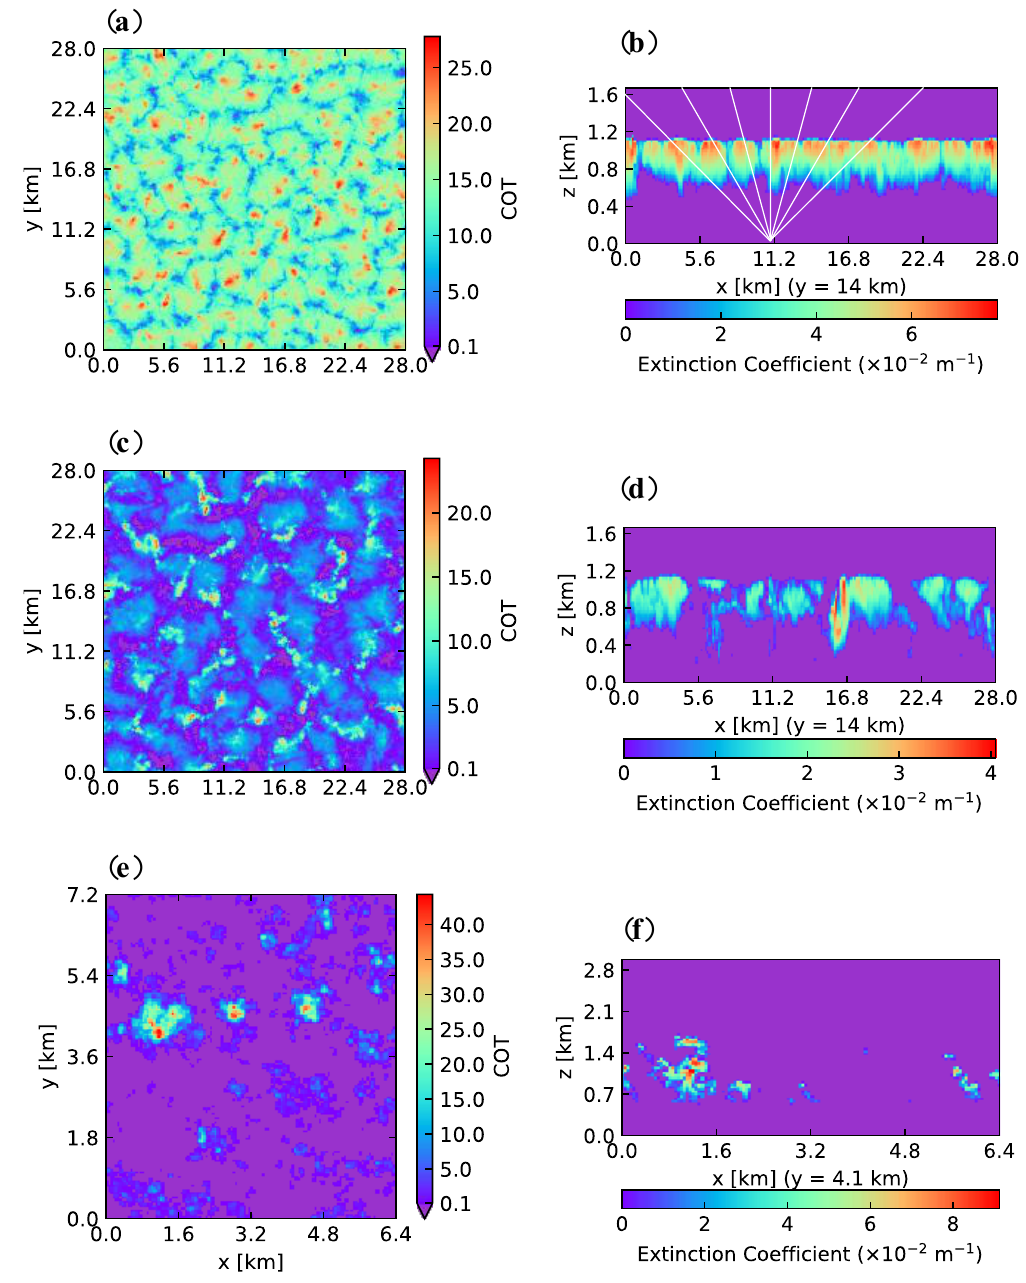
Figure 1. Examples of Scalable Computing for Advanced Library and Environment-Large Eddy Simulation (SCALE-LES) cumulus cloud fields for the following three cases: ( a , b ) closed-cell, ( c , d ) open-cell, and ( e , f ) Barbados Oceanographic and Meteorological Experiment (BOMEX). ( a,c,e ) Horizontal distribution of the cloud optical thickness (COT). ( b , d , f ) Vertical cross section of the volume extinction coefficient along the black dashed lines superimposed on ( a , c , e ), respectively. White lines in ( b ) indicate lines of sight from a ground-based camera.